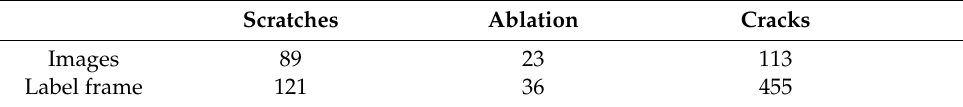
Table 2. Damage statistics in large elbow pipe dataset.